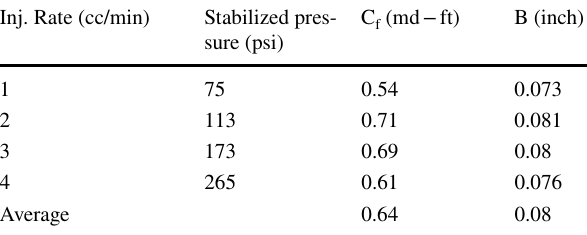
Table 1 Experimental result at different flowrates Inj. Rate (cc/min)